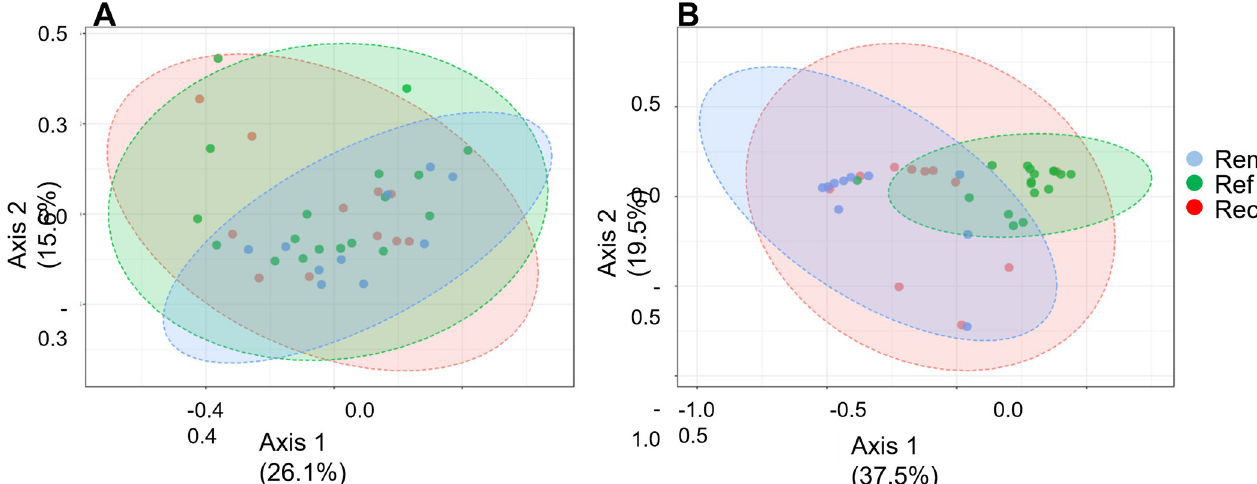
Fig 3. Grouping by overall compositions of patients by PCoA. PCoA analyses were performed separately for pretreatment (A.) and posttreatment (B.) using the MicrobiomeAnalyst.ca platform, inputting raw counts, normalizing with Total Sum Scaling (TSS) without further transformation, and labeling samples after plotting by clinical outcome group. Sample distance was measured using the non-phylogenic Bray-Curtis distance method. The shaded zones represent the range of two-component values with the 95% confidence intervals of observed data for each outcome group. Statistical significance was measured using Permutational ANOVA (PERMANOVA). (A) F-value: 0.96757;R-squared: 0.051012; p-value < 0.504 (top left). (B) F-value: 5.6556;R-squared: 0.24424; p- value < 0.001 (top right).